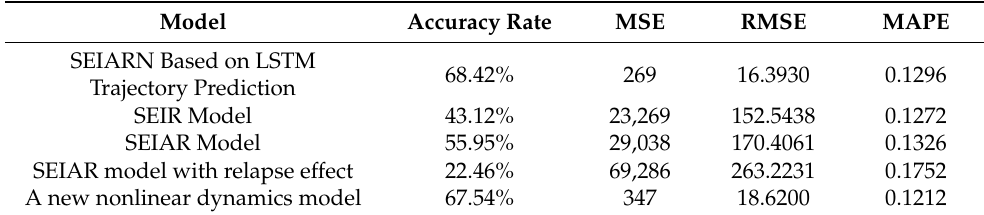
Table 6. Model prediction results of infected